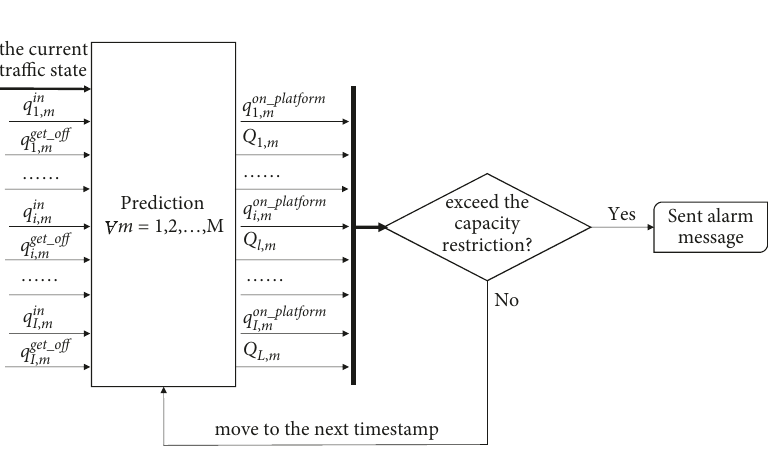
Figure 5: Flowchart of early-warning model.